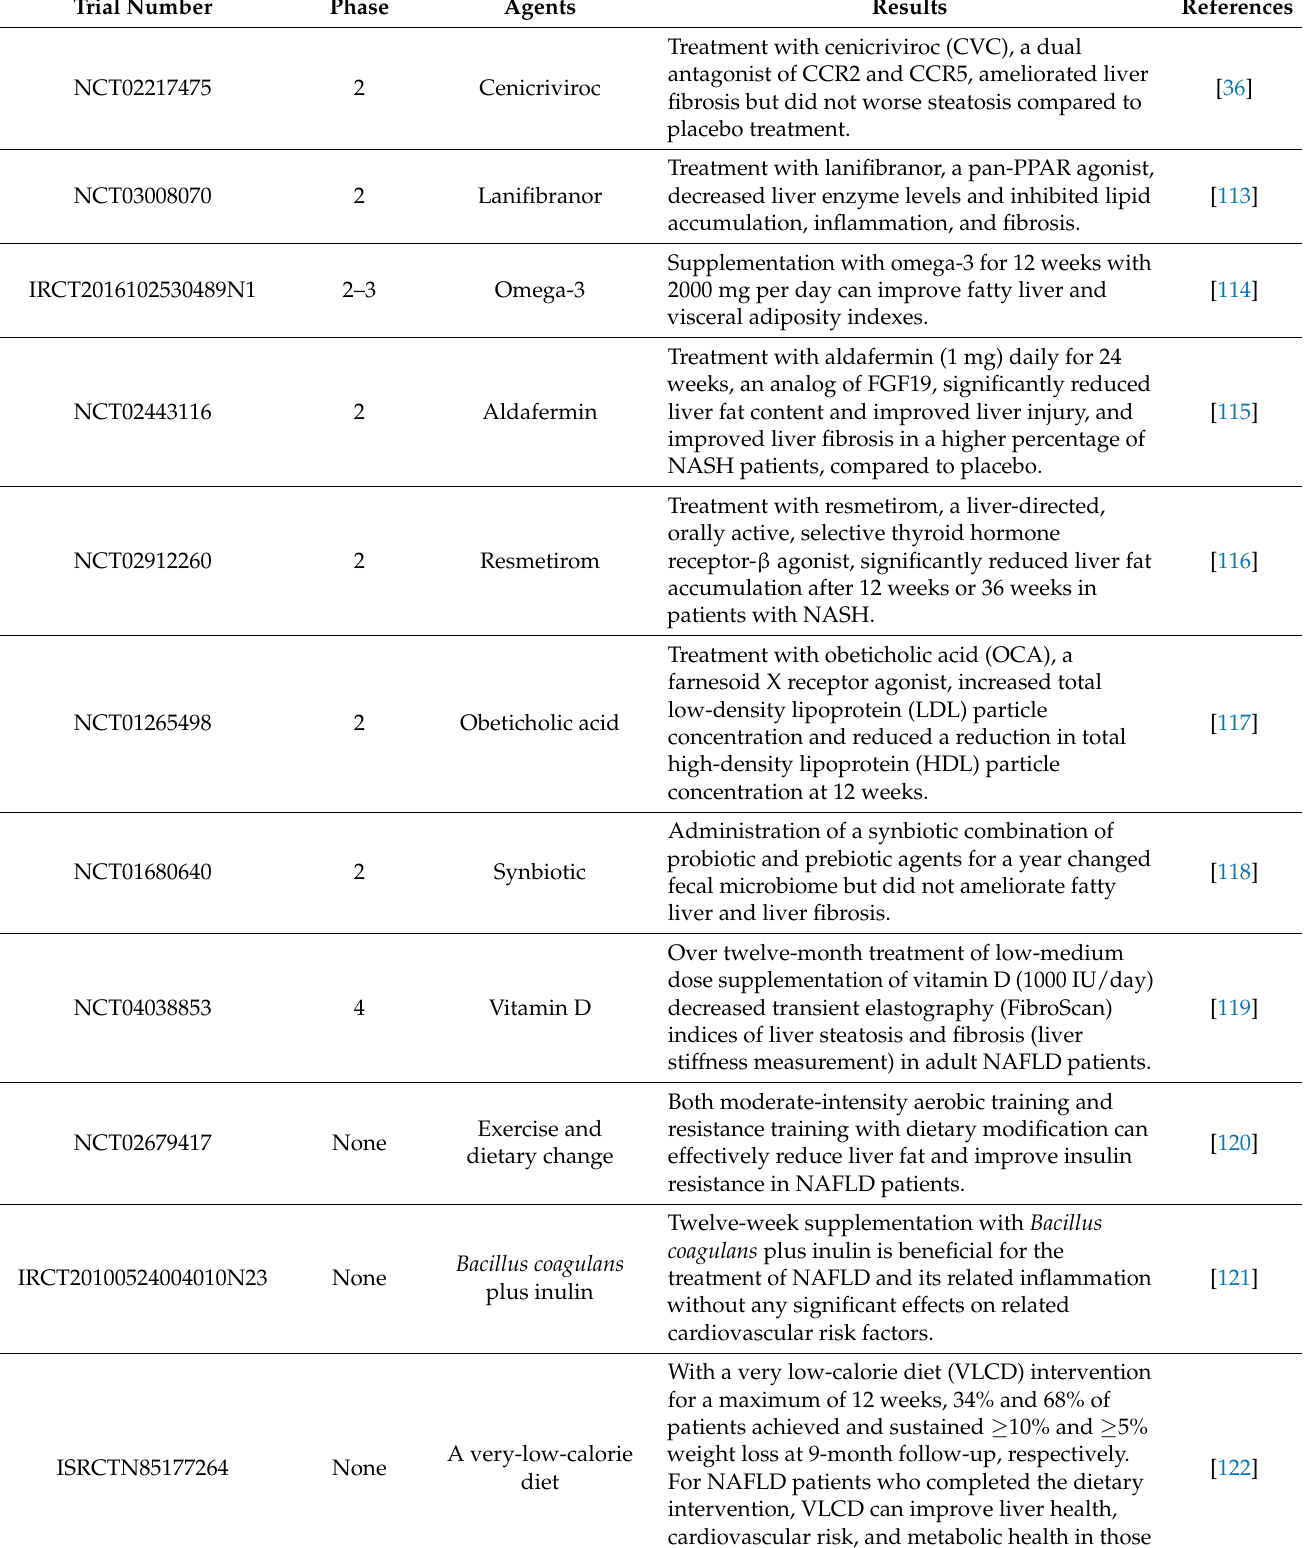
Table 1. Current clinical trials for NAFLD and NASH